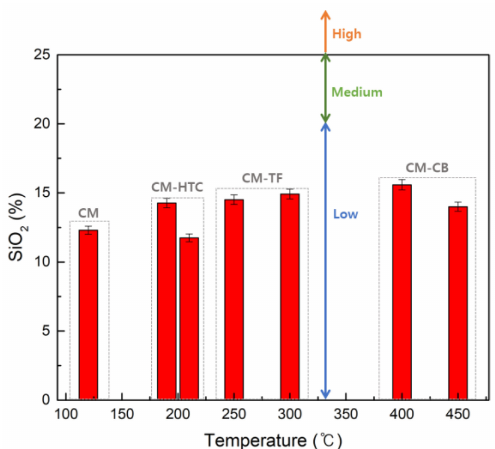
Figure 5. Silicon dioxide content in the cattle manure, hydrochar, torrefied char, and biochar.